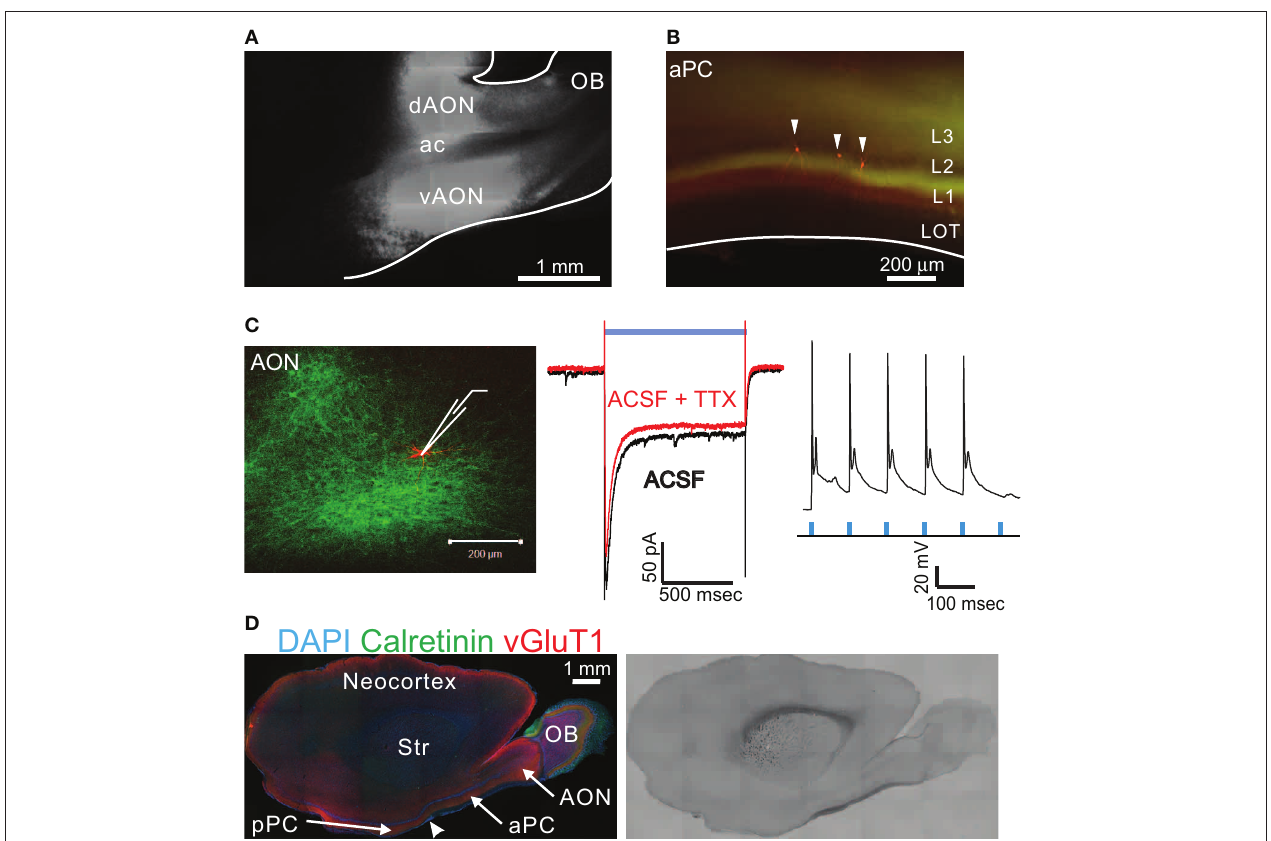
FIGURE 1 | ChR2 expression in AON neurons by virus injection. (A,B) Adeno-associated virus (AAV) designed to express ChR2-EYFP was injected into the rat AON. The strong EYFP signal in the dAON and vAON comes from the expression of ChR2-EYFP in the soma and dendrites of neurons at the injection site. Fluorescence signal was seen coursing into several cortical areas, including the aPC (B) . White arrowheads indicate 3 neurons filled with biocytin during electrophysiological recordings. OB, olfactory bulb; dAON, dorsal part of anterior olfactory nucleus; vAON, ventral part of anterior olfactory nucleus; ac, anterior commissure; aPC, anterior piriform cortex; LOT,